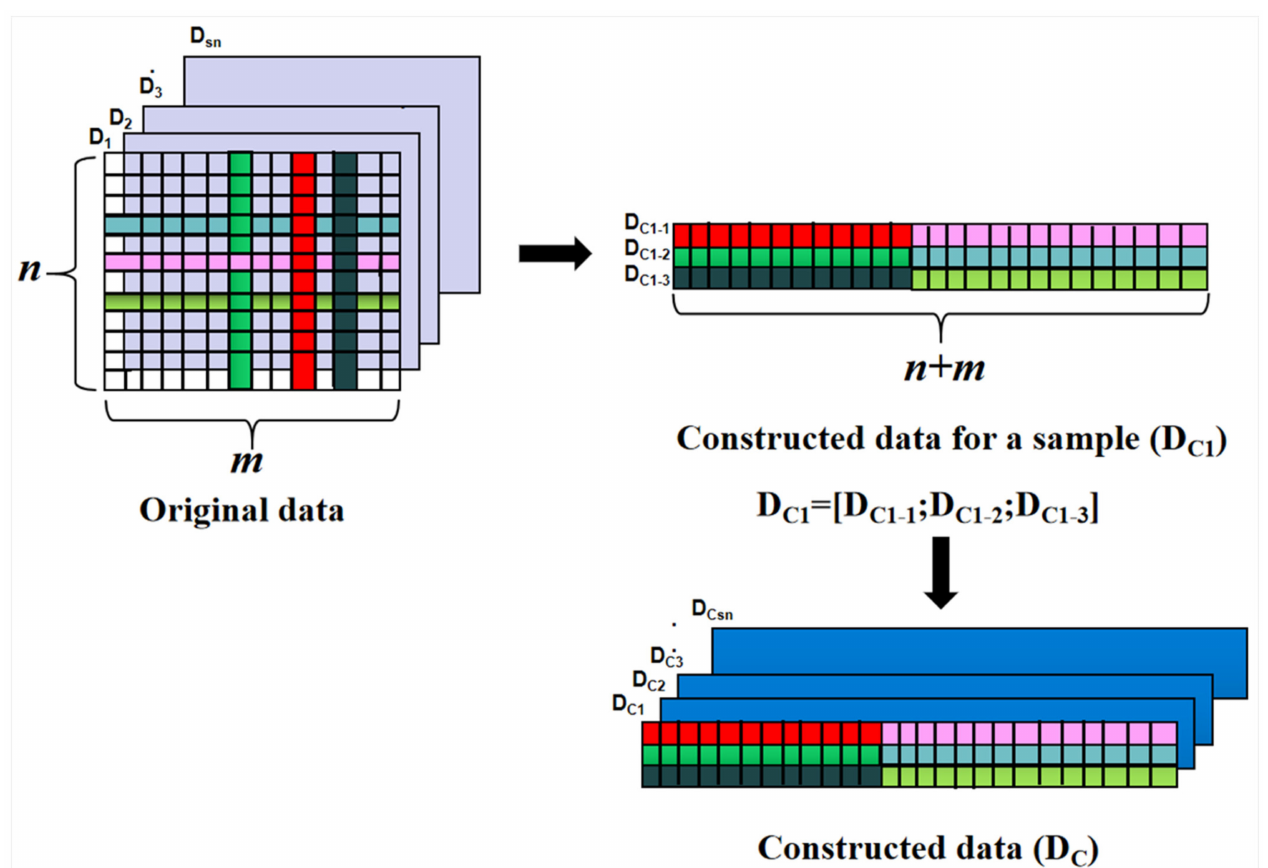
Figure 5. The process of the data